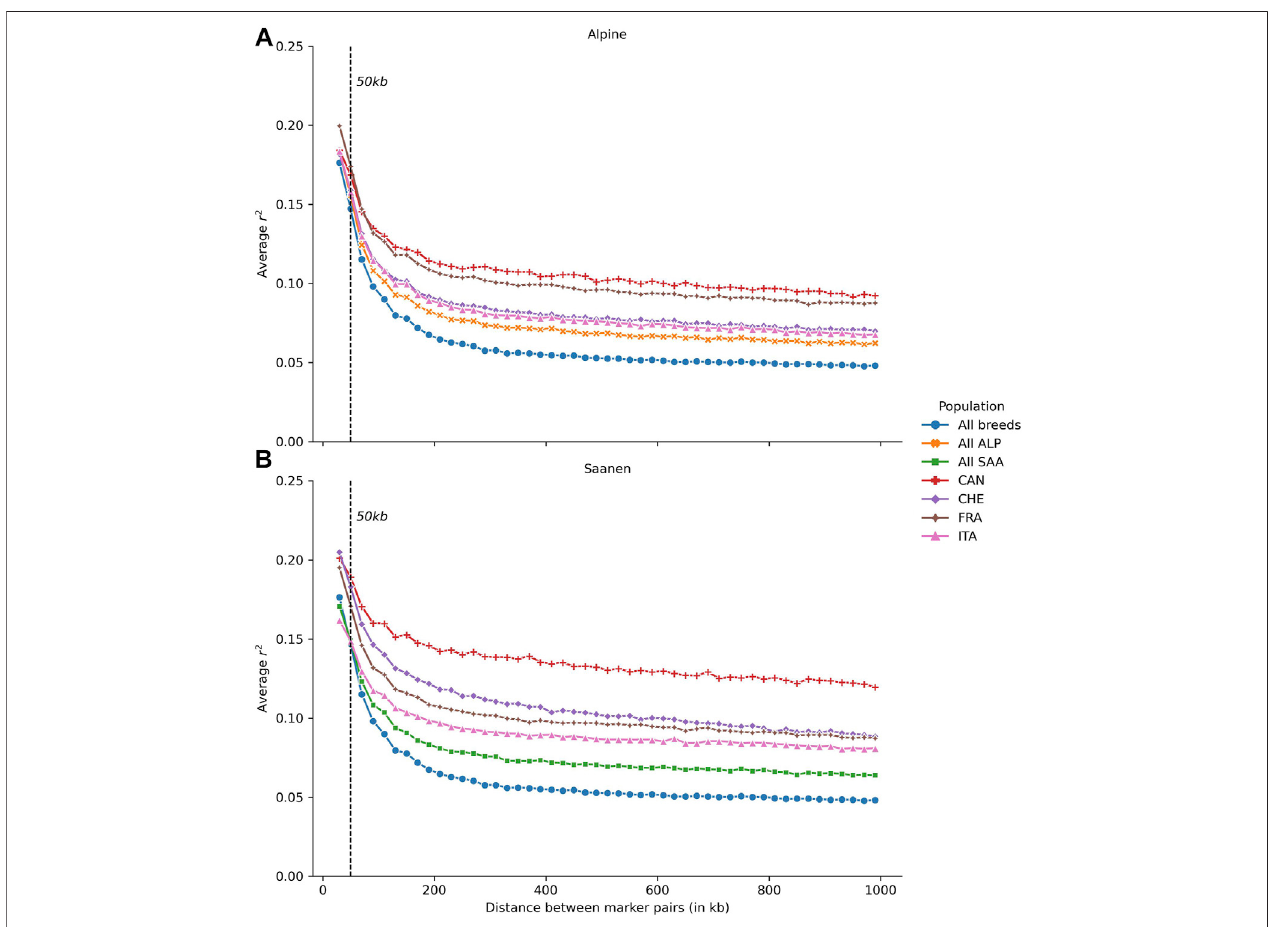
FIGURE 2 | Average linkage disequilibrium (LD) in (A) Alpine (ALP) and (B) Saanen (SAA) breeds, according to the distance between SNPs for each country evaluated: Canada (CAN), Switzerland (CHE), France (FRA), and Italy (ITA) and Saanen from the four countries together (All SAA), Alpine from the four countries together (All ALP), and both Saanen and Alpine goats from the four countries (All